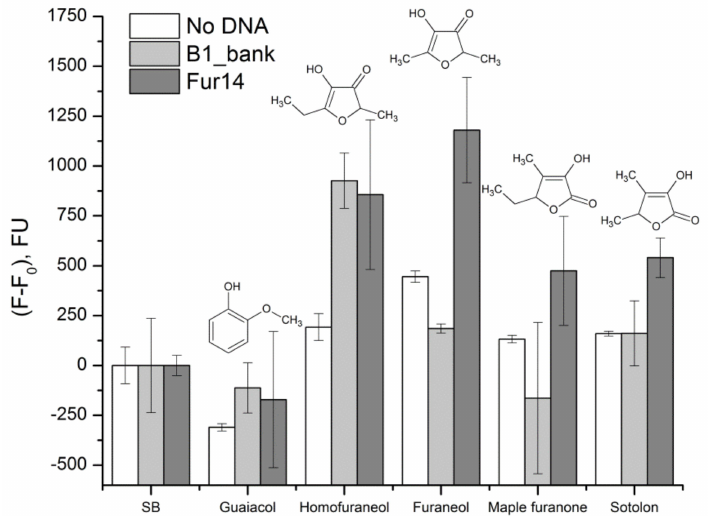
Figure 5. Change of the SYBR Green I fluorescence, after the incubation of Fur_14 oligonucleotide with different targets, 500 µ M each. The B1_bank was used as the non-binding DNA control. Measurements were performed in triplicates. Error bars were calculated as standard